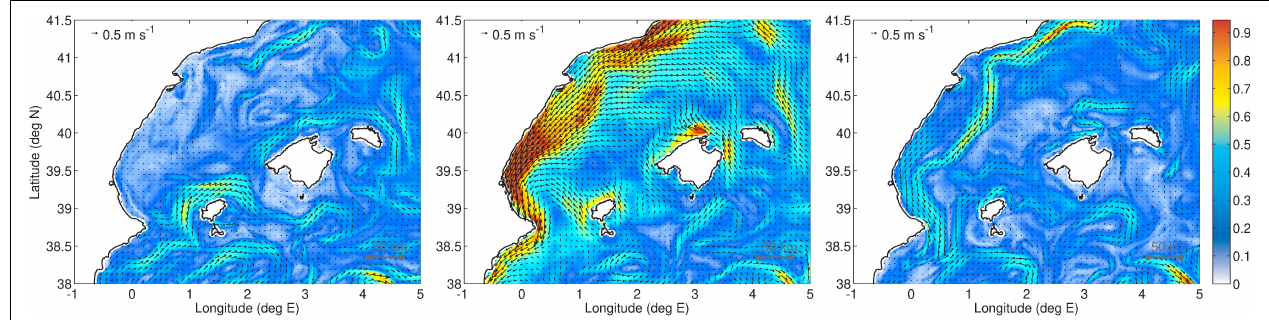
FIGURE 9 | Daily mean WMOP operational forecasts of surface currents (in m.s - 1 ) in the Balearics Islands area for the 18th (left), 20th (center), and 23rd (right) of January